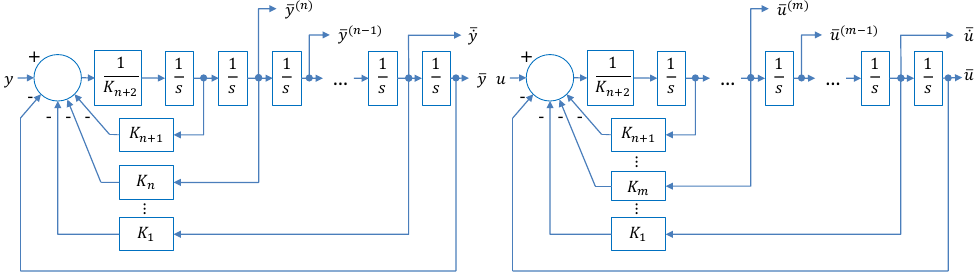
Figure 4. Identical filters with two or more order number than the observed